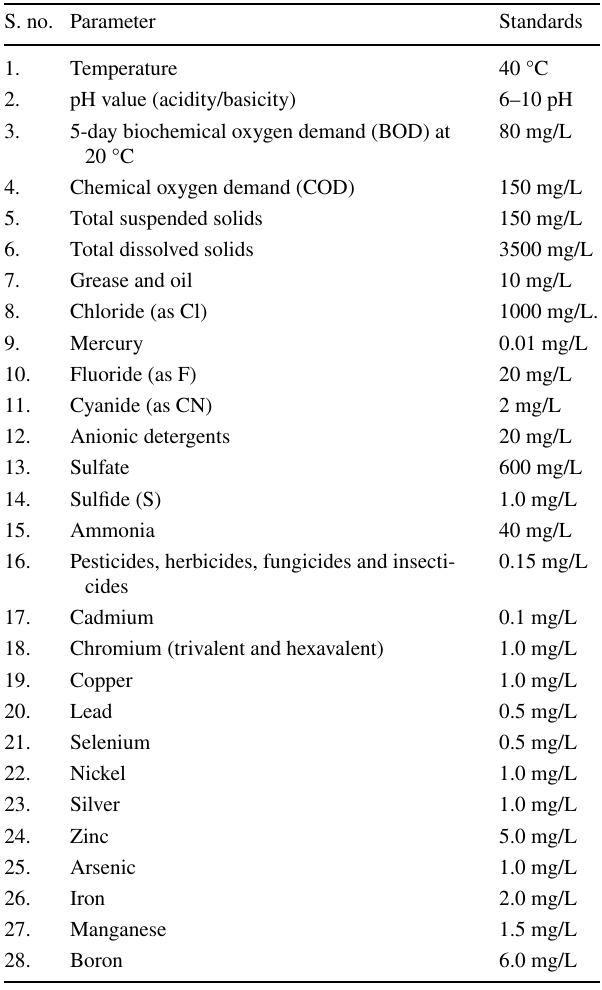
Table 9 National environmental quality standards for industrial